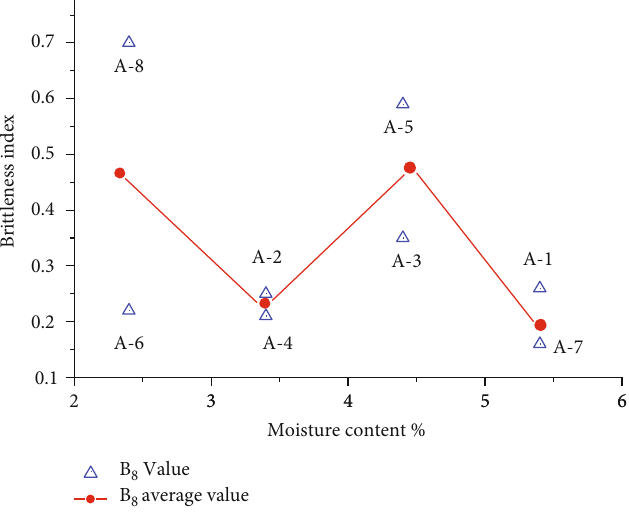
Figure 5: B under di ff erent conditions. 7